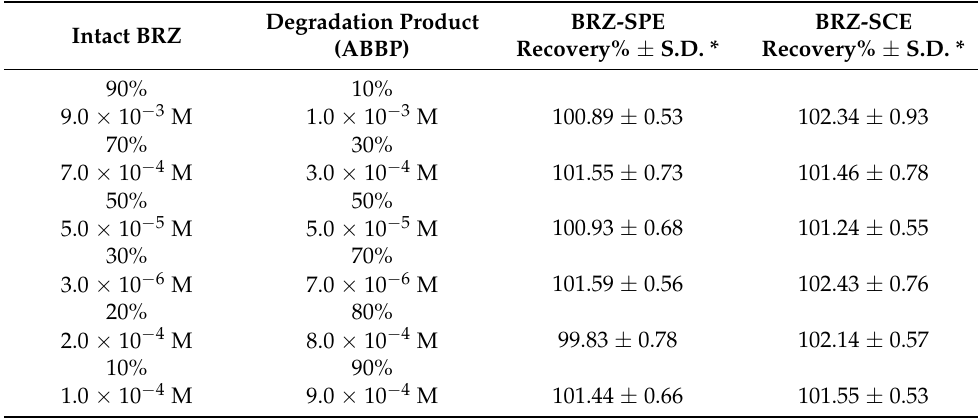
Table 3. Results obtained for the analysis of laboratory-prepared mixtures containing different ratios of intact bromazepam and its main degradation product by the proposed method at 25 ◦